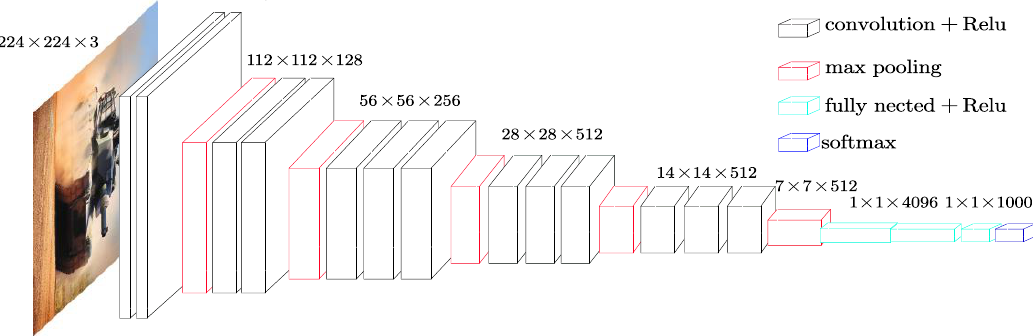
Figure 8. The structure of the Visual Geometry Group (VGG16).